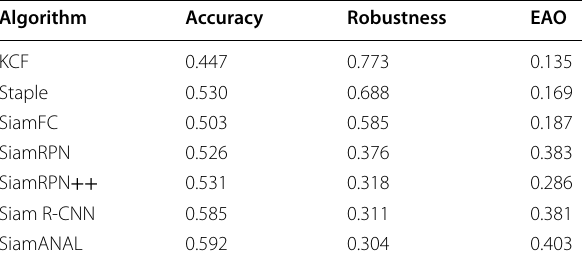
Table 2 Accuracy, robustness and EAO of various algorithms